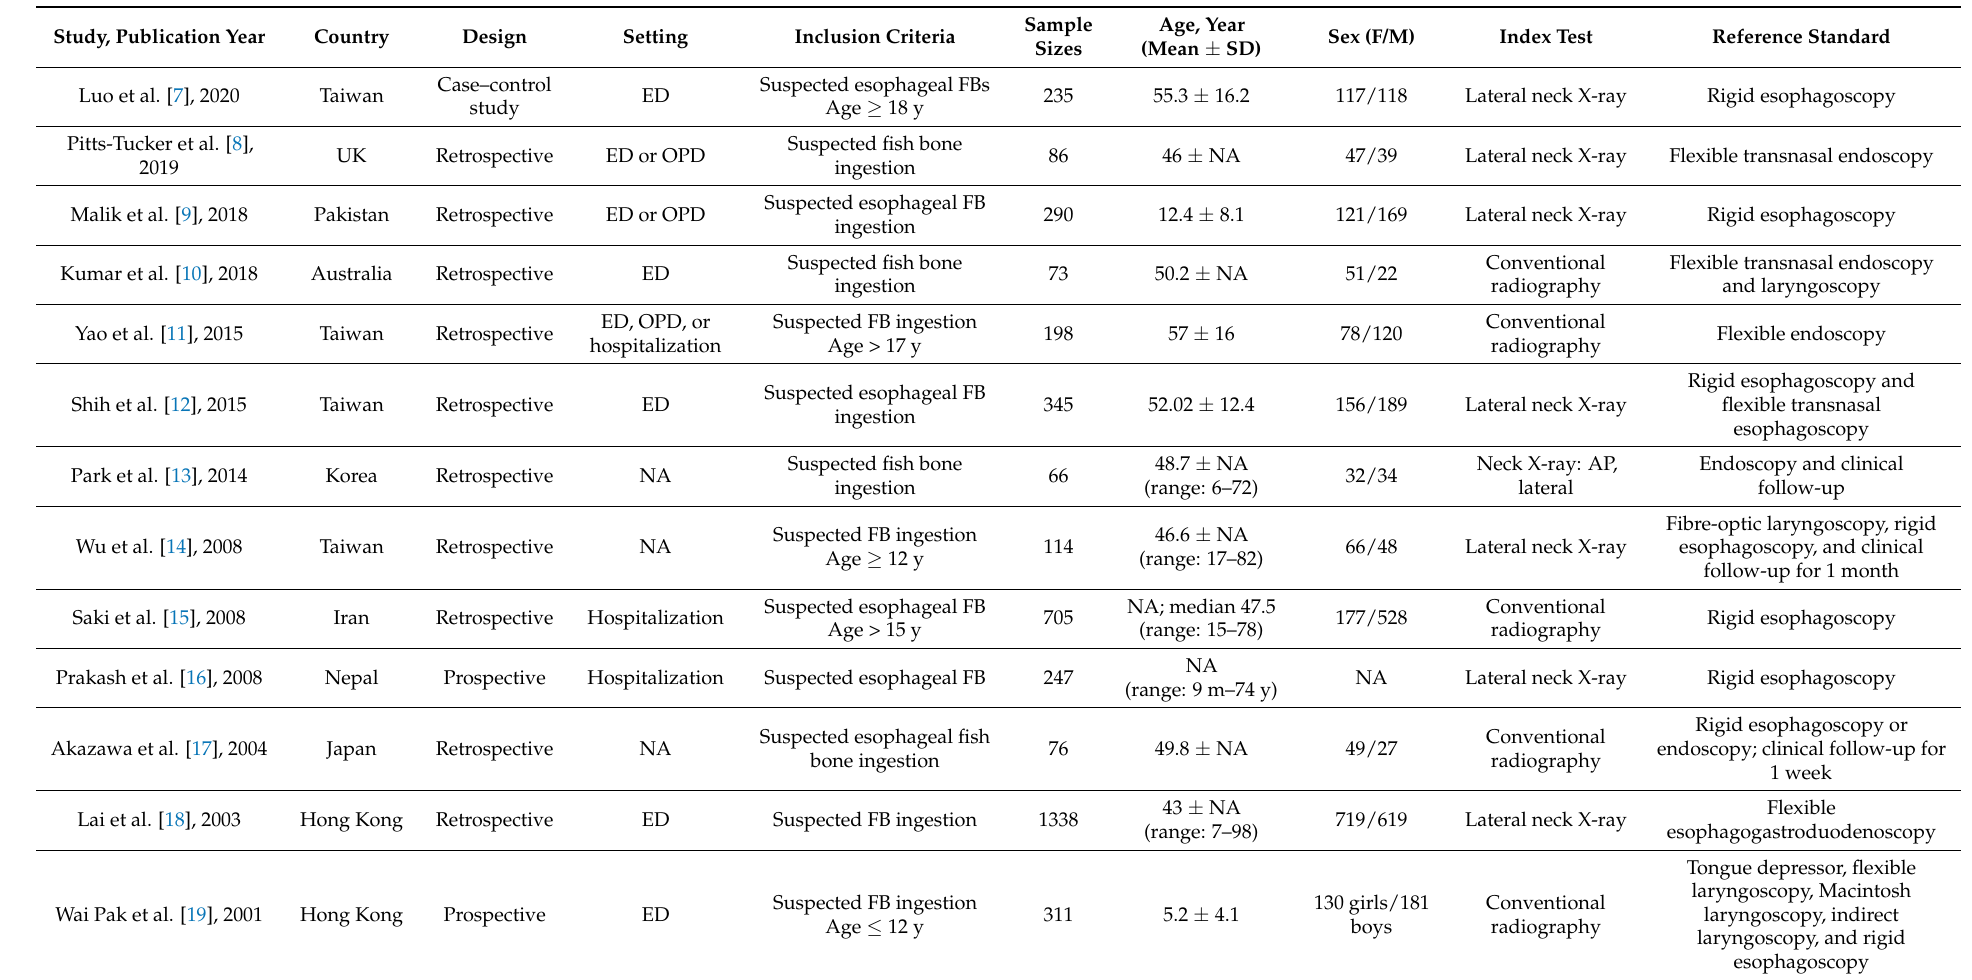
Table 1. Characteristics of studies included in the